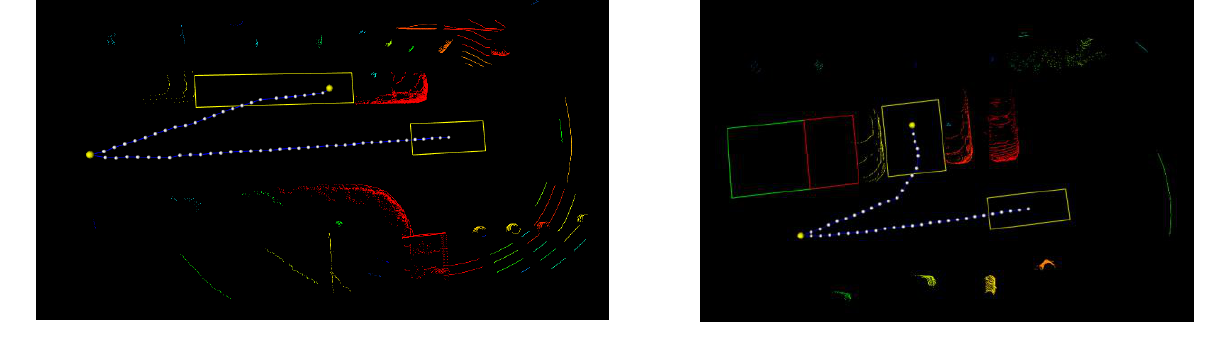
Figure 8. The result of perpendicular parking